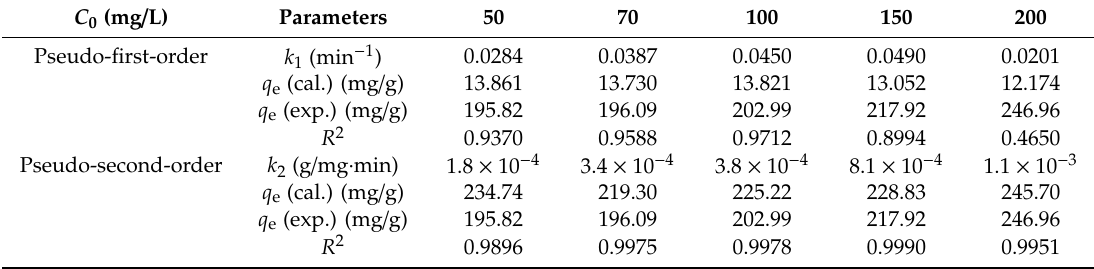
Table 4. The kinetic parameters for the adsorption of Pb(II) onto